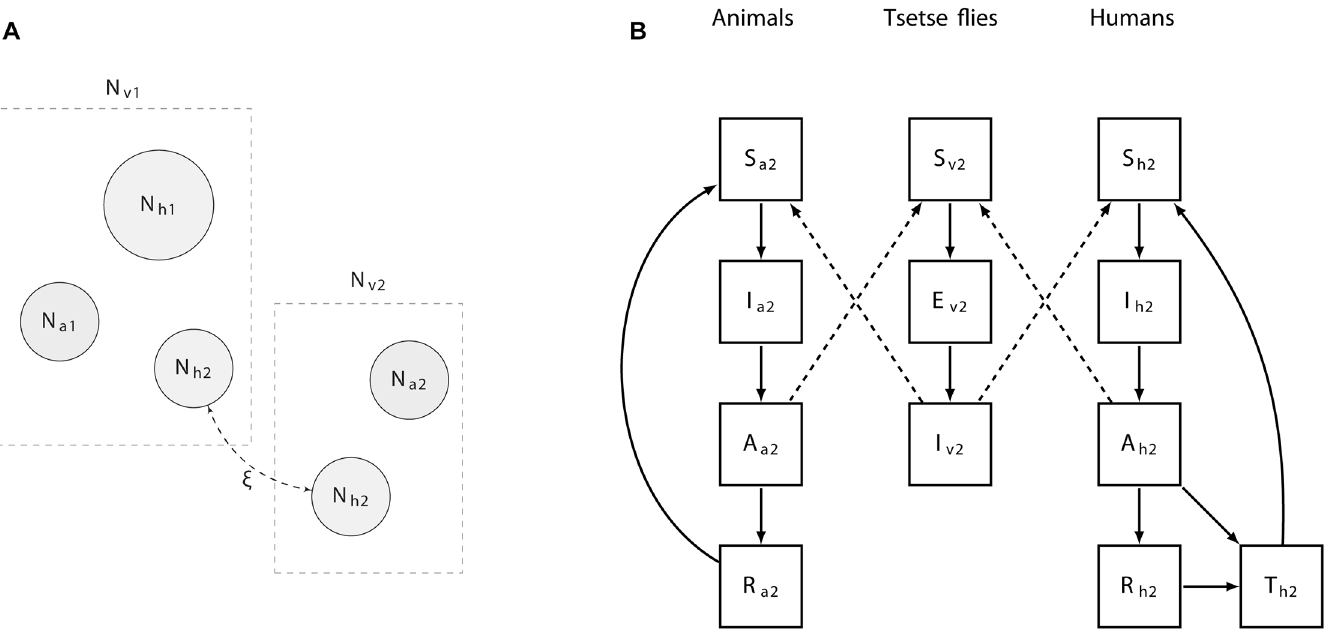
Fig 1. Overview of the population structure and compartments of the model. A): Human populations are divided in a stationary (N h1 ) population that remains in low exposure habitats (e.g., a village), and a smaller population (N h2 ) which commute and spend a proportion ξ of their time in a potentially high exposure setting (e.g., a plantation). Each of these habitats harbours tsetse (N v1 and N v2 ) and non-human vertebrate animal populations (N a1 and N a2 ) of varying sizes and characteristics. B): Compartmental diagram highlighting the transmissions between states of infection of the animal, tsetse, and human populations in the high exposure area 2. A similar diagram explains transmission in area 1, although there both human populations are exposed to tsetse bites. Solid lines depict transitions between compartments, while dashed lines represent transmission rates.